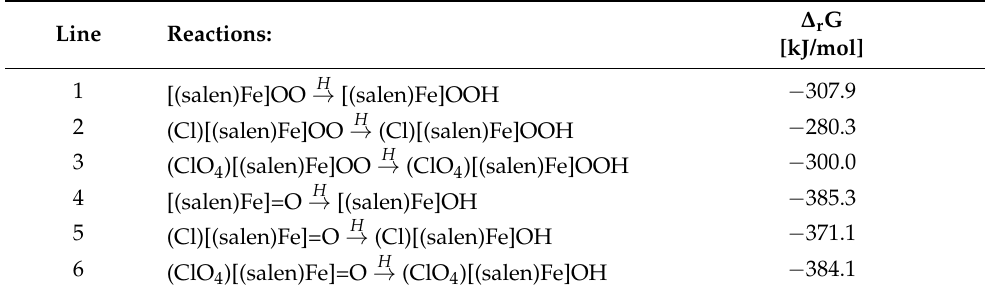
Table 3. Reaction Gibbs free energy for catalyst activation modeled as an attachment of a hydrogen atom to the complex.